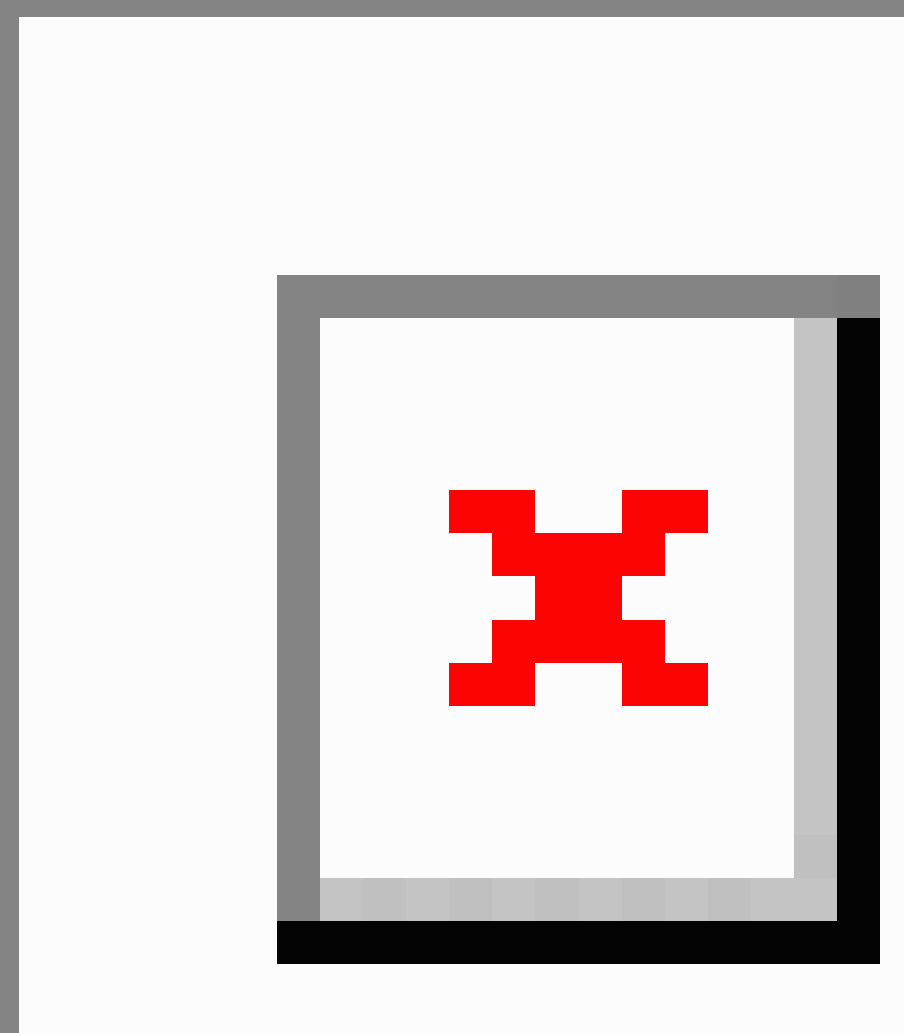
Figure 1. HiveQL query to count the total number of tweets.